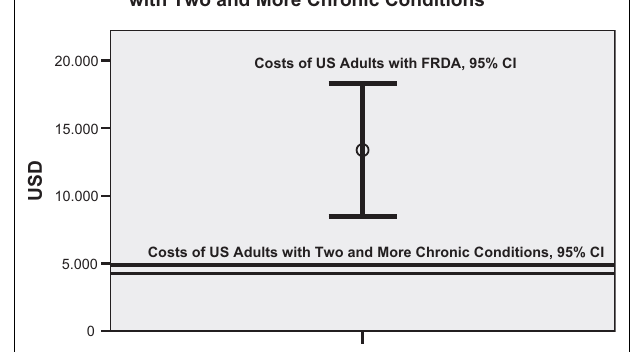
FIGURE 1 | Comparison of mean healthcare costs of US adults with FRDA and of US adults with two and more chronic conditions (95% CI) . (N.B.: the analysis of healthcare costs of US adults with two and more chronic conditions by Machlin et al. (2008) was based on MEPS data which included more than 30,000 individuals.The considerably different sample size of the compared populations contributed to the different sizes of the 95% confidence